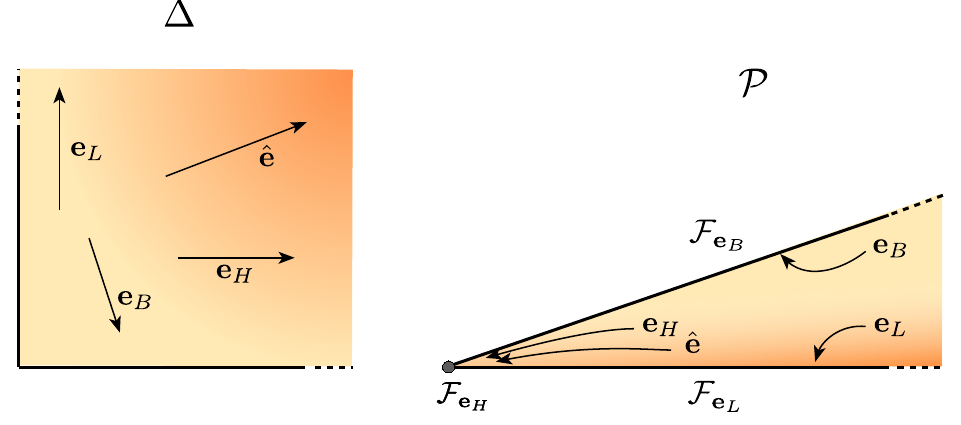
Figure 5 . Examples of saxionic string flows (4.9). On the left, string flows in the saxionic cone ∆ (the s 0 direction is suppressed) and, on the right, their maps in the dual saxionic cone P (the ‘ 0 direction is suppressed). The charges e H , e L , e B are elementary, while ˆ e = (0 , 1 , 3) is not. The picture also shows that the e B flow approaches the finite distance boundary s 2 = 0 of ∆ and, correspondingly, F e lies in the strongly coupled light shaded region of P B